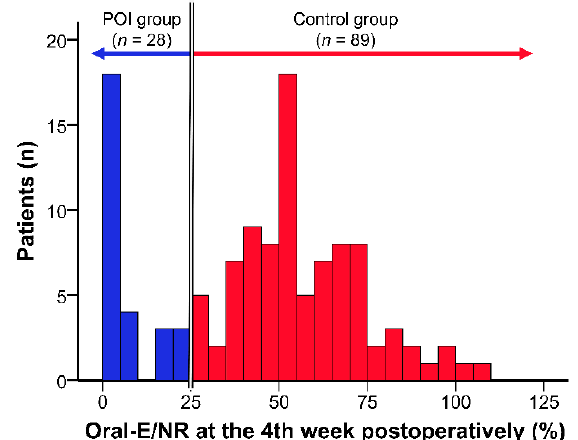
/ NR at the 4th week Figure 1. The distribution of oral-E/NR at the 4th week postoperatively. Figure 1. The distribution of oral-E